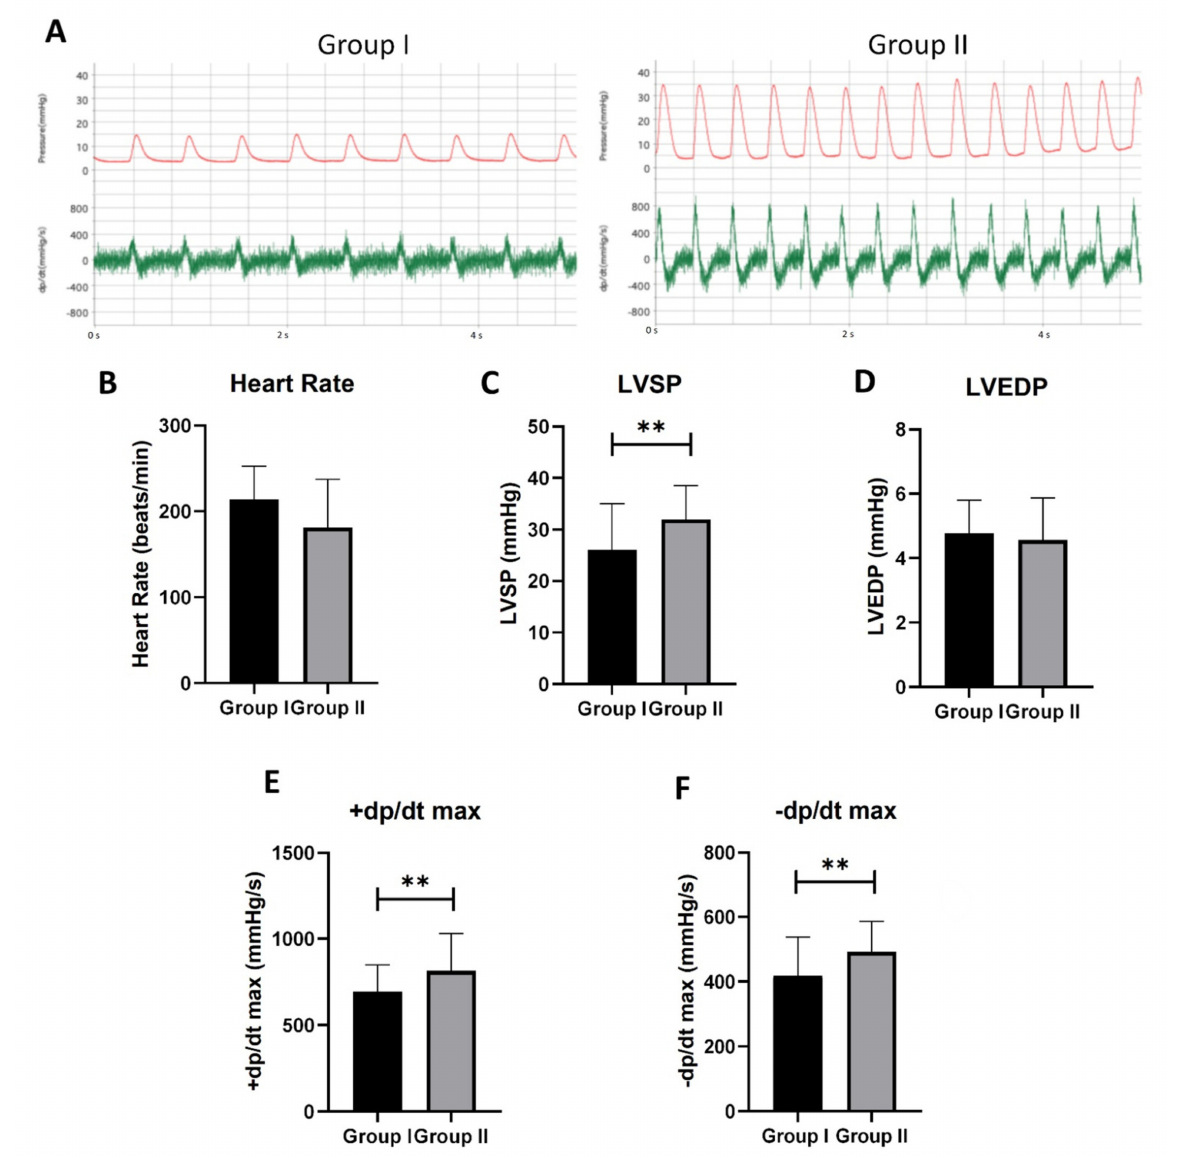
Figure 5. Graft function analyzed by Millar pressure catheter. ( A ) The representative LabChart images of Groups I and II. The red wave represents the left ventricle pressure (mmHg). The green wave represents the ± dp/dt (mmHg/s). ( B ) Heart rate ( p = 0.309). ( C ) Left ventricle systolic pressure (LVSP). ( D ) Left ventricle end-diastolic pressure (LVSP) ( p = 0.439). ( E ) The maximum dp/dt in the systolic period. ( F ) The maximum dp/dt in the diastolic period. The first nine waves of each sample were measured. n = 5, ** p <